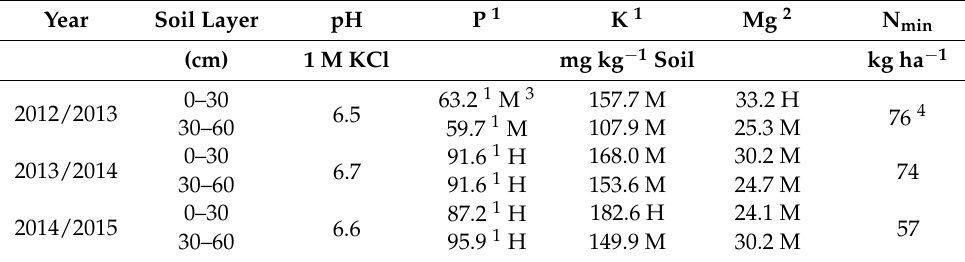
Table 3. Soil characteristics of the experimental plots during the 2012–2015 growing seasons. Year Soil